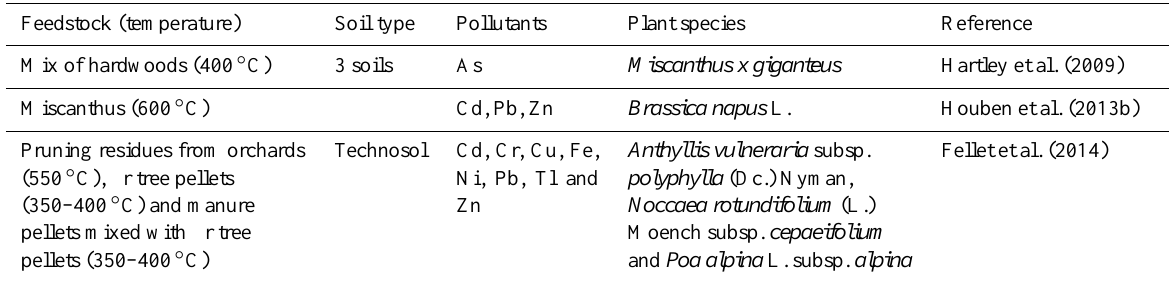
Table 2. Studies considering the effect of biochar application on soil heavy metals in combination with phytoremediators. Blank indicates not specified in the article.